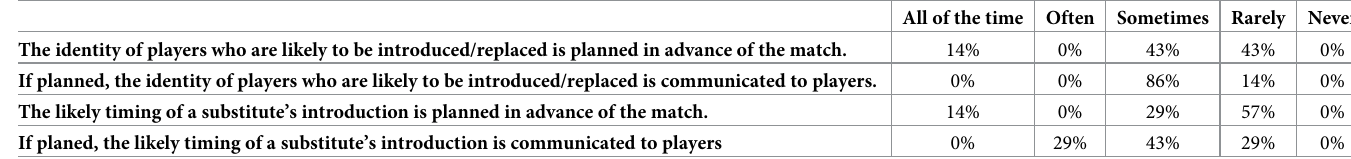
Table 2. Tactical practitioner responses relating to substitution planning (n =